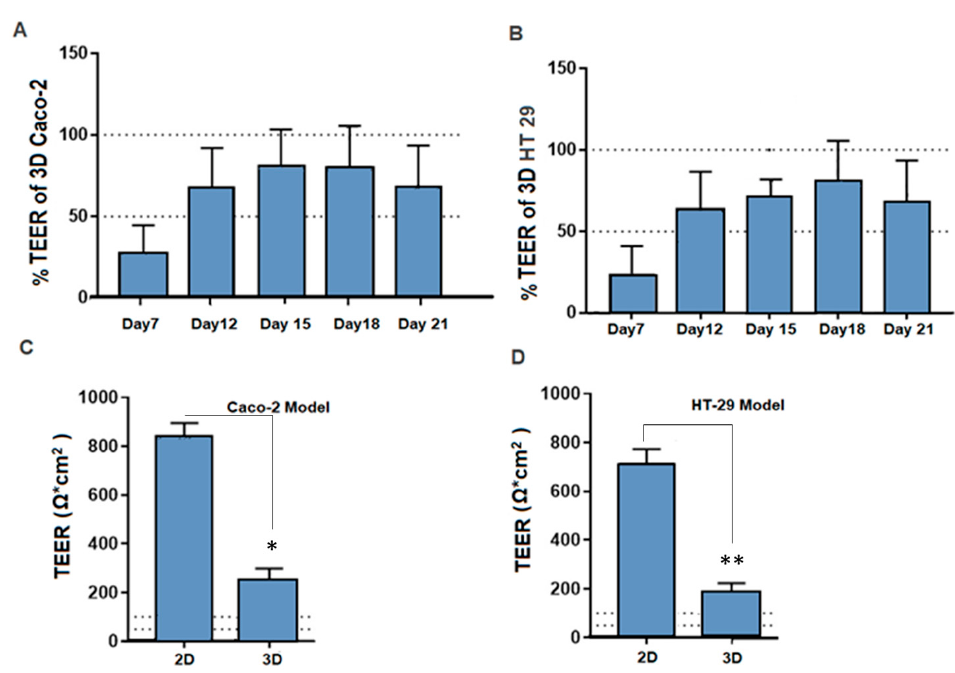
Figure 4. Barrier function of 3D-printed constructs. ( A ) Transepithelial electrical resistance (TEER) was determined for 3D-printed Caco-2 cells from day 7 to day 21, showing an initial increase in culture, with barrier function maintained at normal physiological conditions (dotted lines) after day 12 ( n = 24). ( B ) The transepithelial electrical resistance (TEER) was determined for 3D-printed HT-29 cells from day 7 to day 21. ( C ) Comparison of TEER values between 3D-printed Caco-2 cells ( n = 24) versus 2D Caco-2 ( n = 5). ( D ) Comparative TEER values between 3D-printed HT-29 cells ( n = 24) and 2D HT-29 ( n = 5). Data are represented as mean ± SD; * p < 0.05 and ** p < 0.01 were considered statistically significant differences as compared to 2D and 3D cell culture models for both Caco-2 and HT-29.